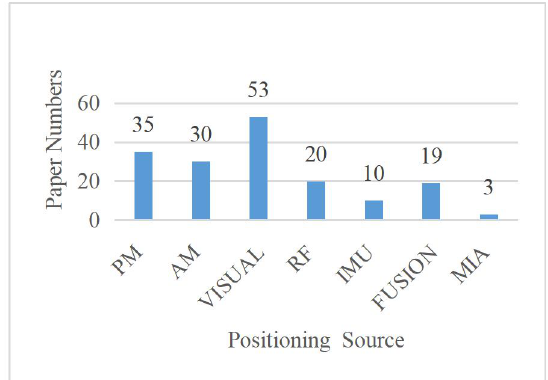
Figure 3. Histogram of CE positioning